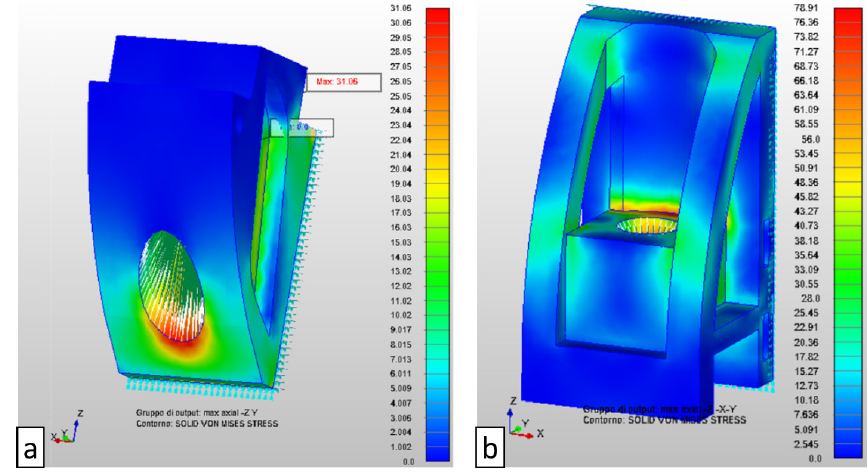
Figure 10. FEM simulation of the new upper ( a ) and lower ( b ) junction points.